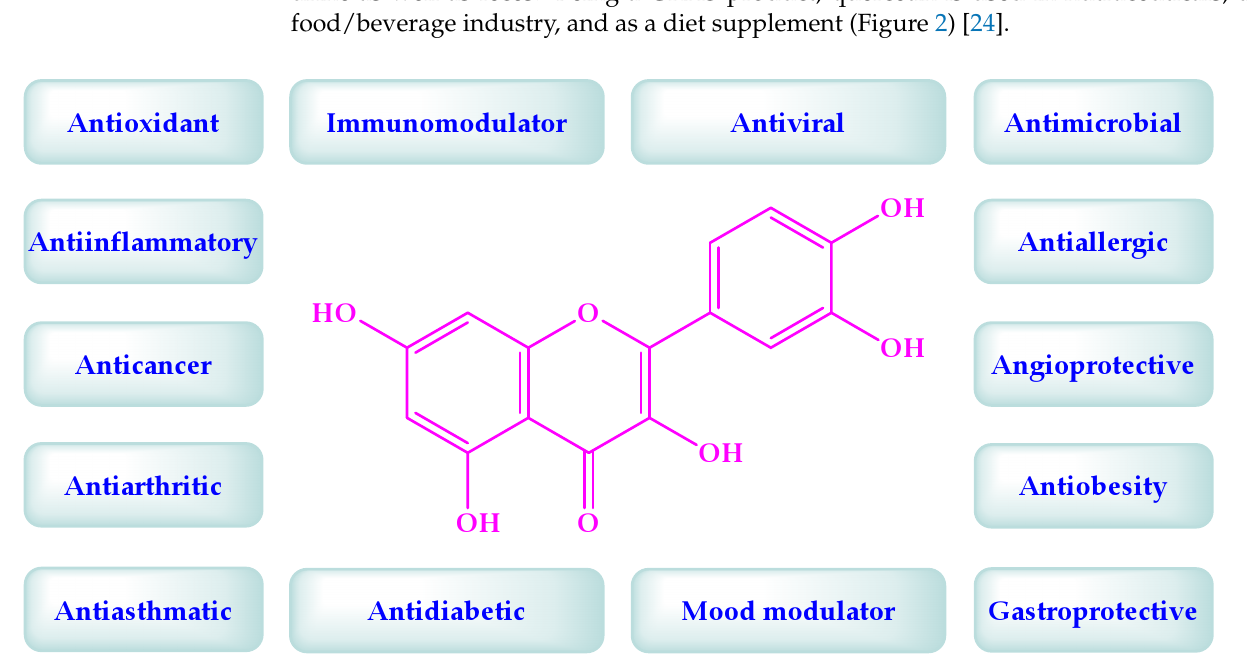
Figure 1. Chemical structure and biological effects of quercetin [18,21,22].